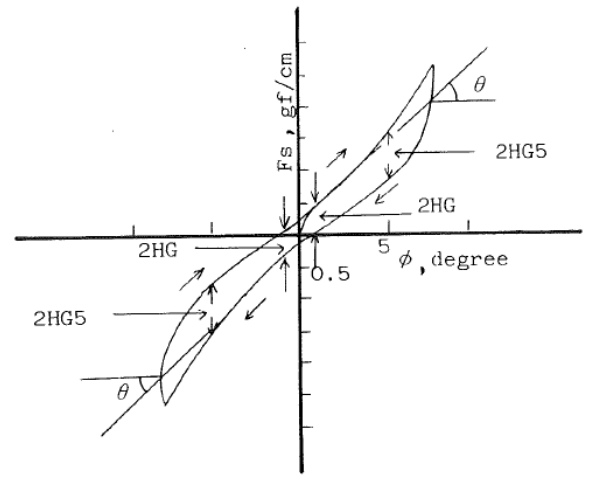
Figure 12. Typical shear force-shear angle curve of woven fabric.